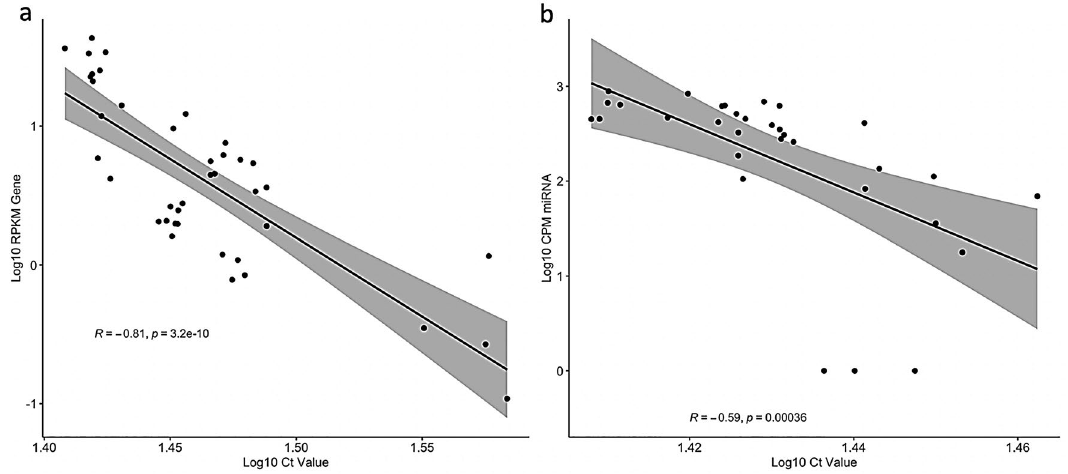
Figure 5. Correlation between Ct values from qPCR and normalized sequencing reads mapped to select genes ( a ) and miRNA ( b ). Gene sequencing reads were normalized for library size and gene length using RPKM, while miRNA reads were normalized for library size using CPM. Both sets of data passed Shapiro–Wilk tests of normality (p > 0.05). The linear regression line, confidence interval, Pearson’s correlation coefficient, and significance value are